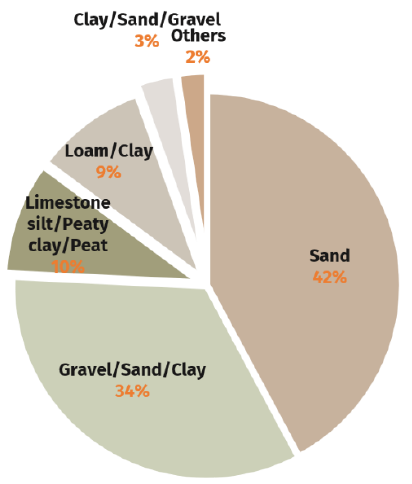
Figure 4. Frequency of lithological types of soil across the surveyed ponds.